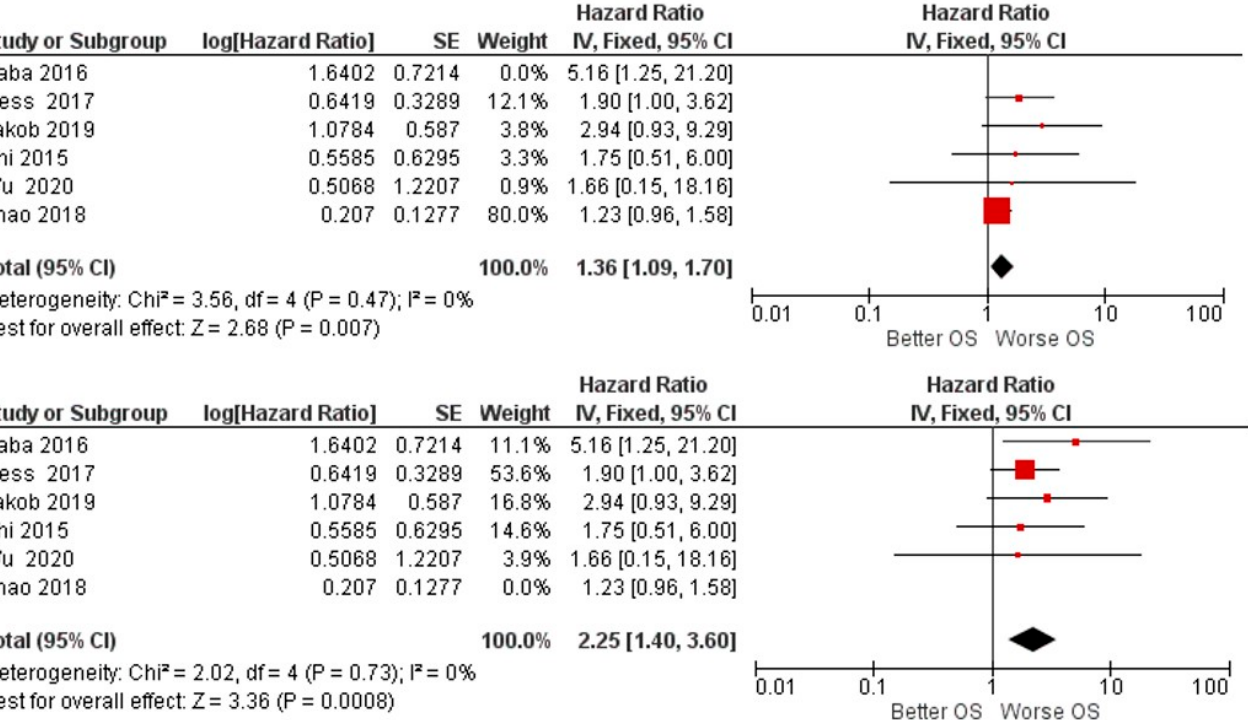
Figure 6. Sensitivity analysis: by excluding the two studies, Zhao 2018 and Baba (2016), the heterogeneity drops ( I 2 = 0%), The final effects always remain in favor of a worsening of OS for patients with high expressions of miR-155 tissue. Excluding Baba, HR is 1.36 [1.09, 1.70]; excluding Zhao, HR is 2.25 [1.4, 3.60].